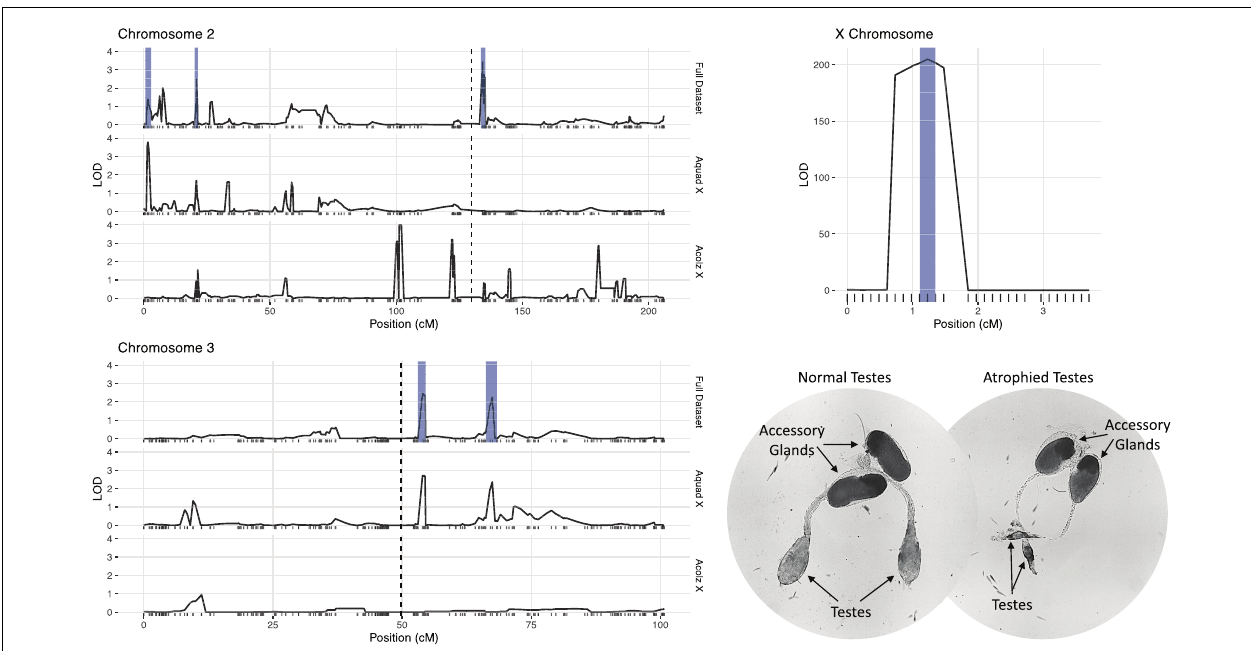
FIGURE 3 | LOD plots for hybrid male sterility QTL identified with composite interval mapping in the An. coluzzii × An. quadriannulatus cross. Note the differences in the y -axis scales between the chromosome 2 (top left) and 3 (bottom left) panels, and the X chromosome panel (top right). Vertical, dashed lines indicate centromere locations on chromosomes 2 and 3. Second and third chromosome right arms are left of the centromere, and left arms are to the right. Vertical blue bars indicate 1.5 LOD intervals of QTL that explain a significant proportion of phenotypic variation in multiple imputation QTL model of the full dataset. The bottom right panel illustrates the gross morphological differences between hybrid testes with a normal sterility score (1) and a atrophied hybrid testes (sterility score = 6) which contain no sperm or only a few sperm with abnormal morphology. TABLE 2 | Genomic regions of QTL in physical (Mb) and map (cM) distances.